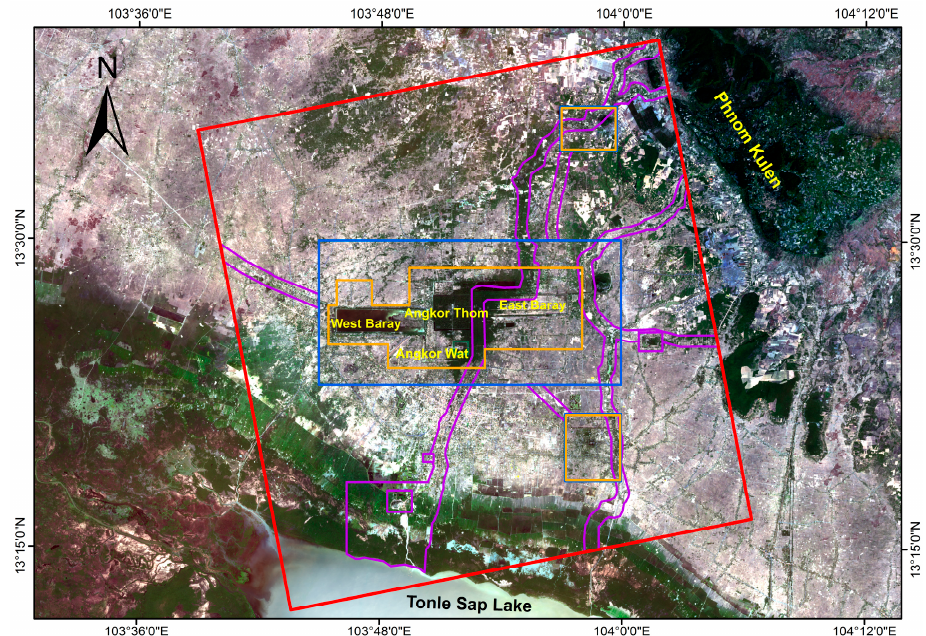
Figure 1. Location of Angkor (Landsat 8 data acquired on 12 February 2017) with the study area highlighted by the red rectangle. Core zone highlighted by orange layer, buffer zone highlighted by blue layer, protected cultural landscape area highlighted by purple